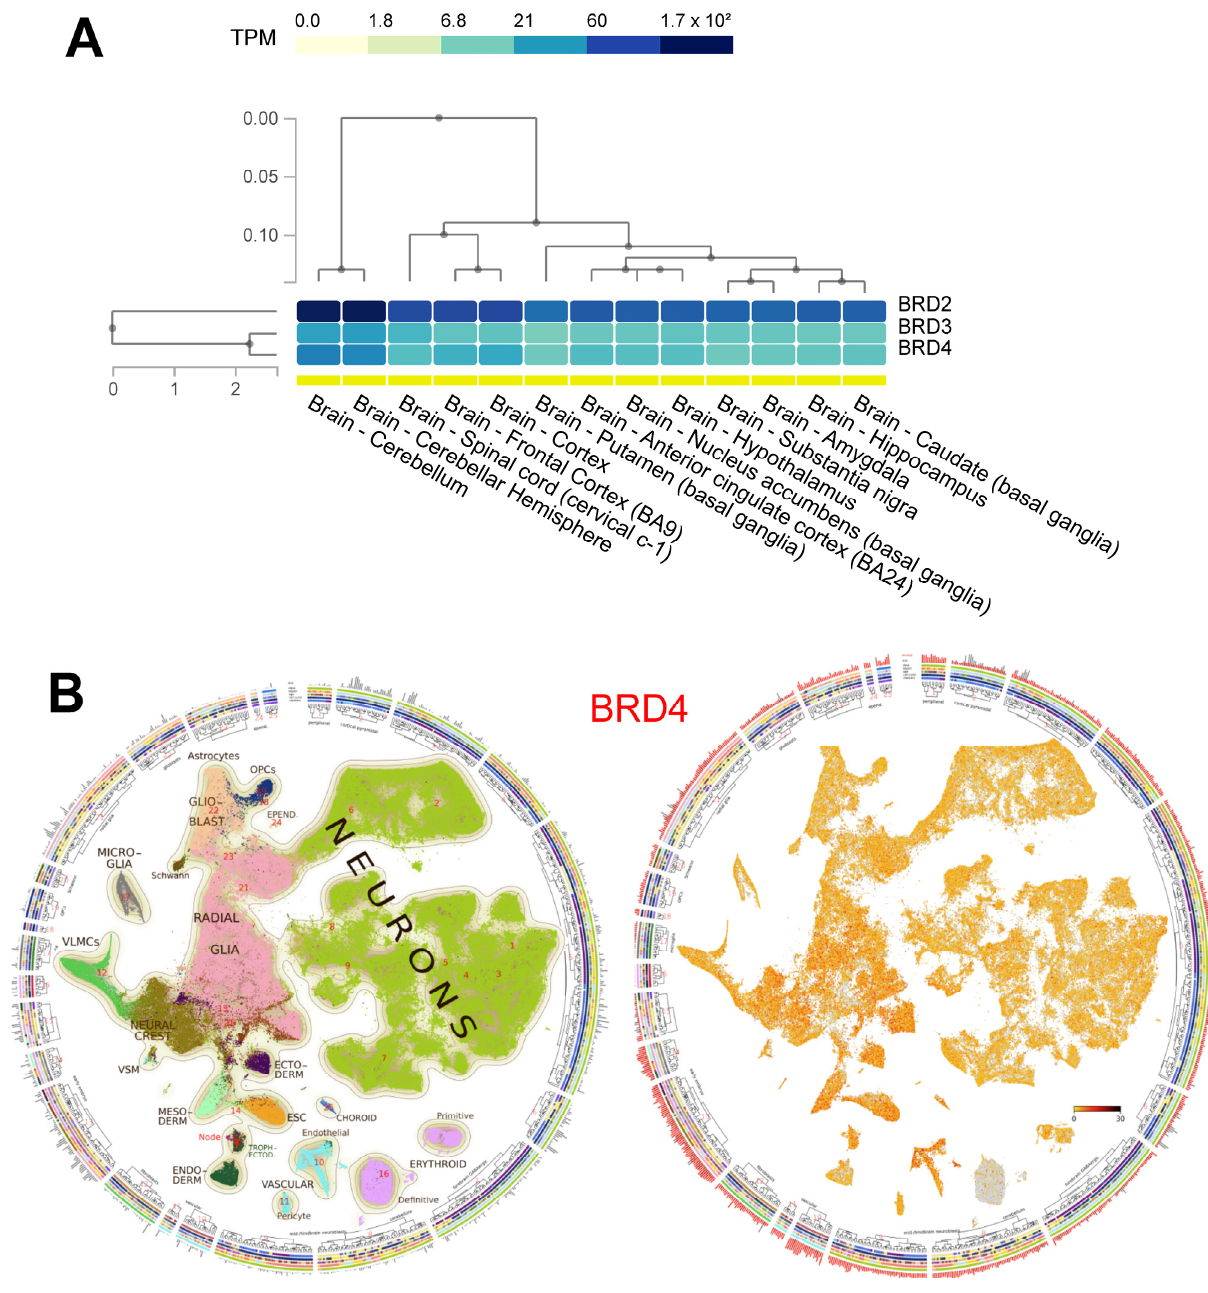
Figure 1. BET protein expression in the central nervous system. ( A ) Human bulk RNA expression from the GTex database, clustered by brain tissue type [34] ( B ) Single-cell RNA sequencing atlas